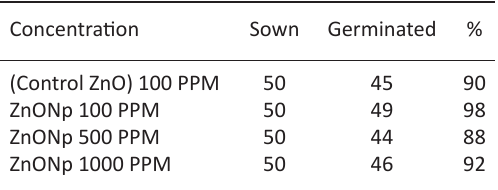
Table 6. Effect of ZnONp on Seed Germination % of Gram ( Cicer arietinum ) Concentration Sown